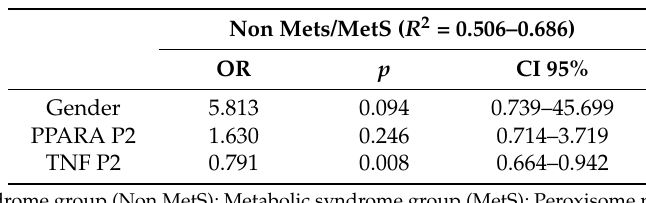
Table 6. Logistic regression analysis: risk of MetS. The regression was conducted using a step method to look for the most harmonized model. Variables that showed a significant association with the MetS index at the correlation analyses, such as Age, gender, PPARA P2, SCD P6, and TNF P2 to P5, were introduced as independent variables and a harmonized model in which gender, PPARA P2, and TNF P2 were maintained was